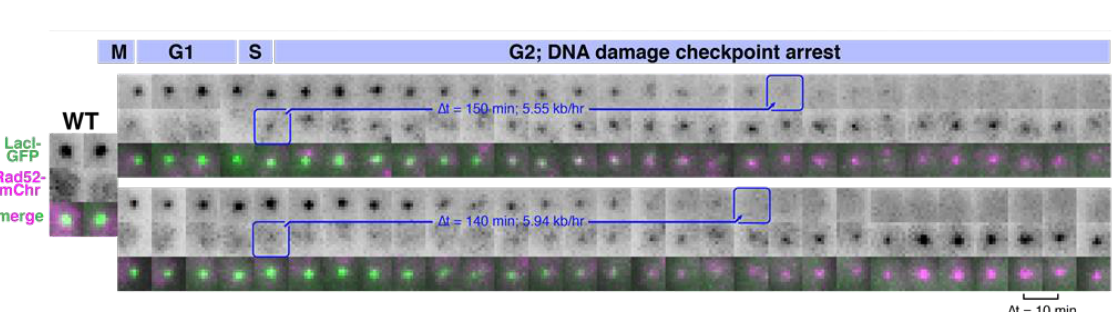
FIGURE 20: Microscopy-based assay for quantitative measurement of DSB end resection rates in single cells. (A) Cartoon diagram of the assay principles, including a recognition site for the HO nuclease adjacent to a LacO array. Resection drives loss of LacI-GFP and binding of Rad52-mCherry. On the right are examples of images that highlight the phases of DSB induction and processing. (B) Time-lapse movie of two sister cells that each form a DSB in S phase and undergo resection. The first frame when Rad52-mCherry is detected at the DSB and last frame in which the LacI-GFP focus is detected are boxed in blue. This gives rise to the resection duration, from which the resection rate can be calculated (blue). The time intervals are 10